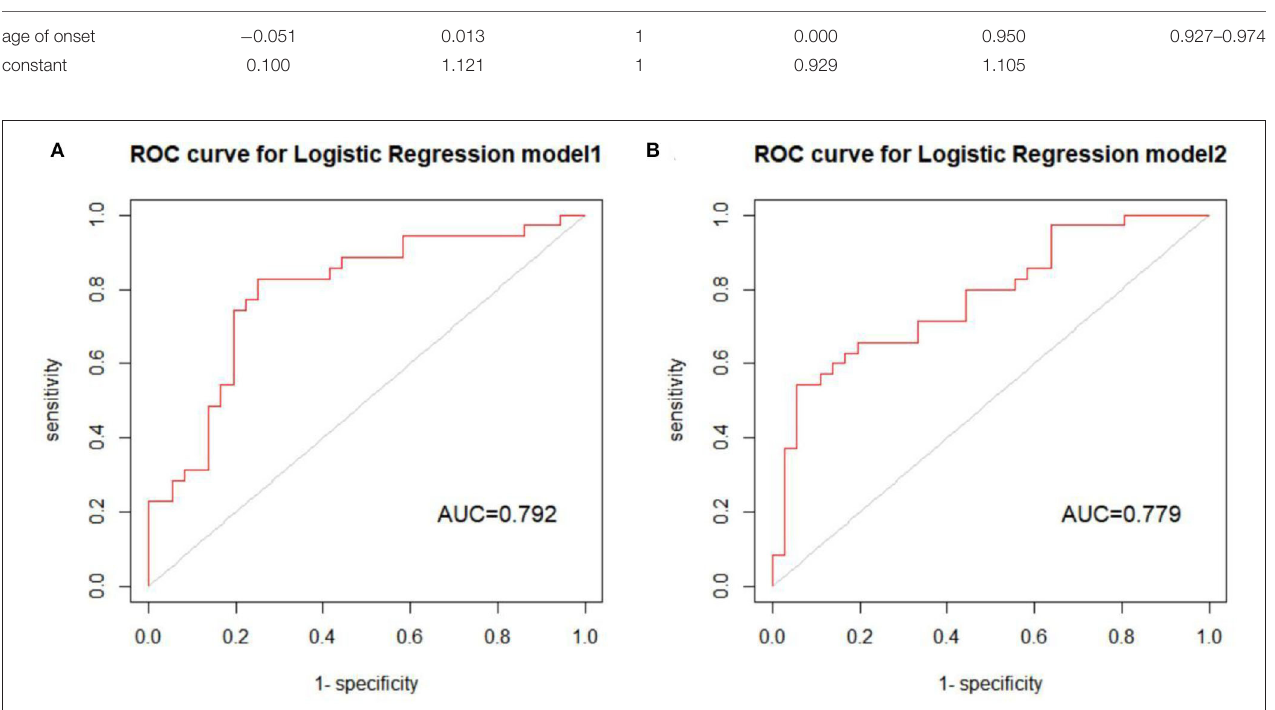
model1 was higher than model2, however, there is no significant difference between the AUC value of model1 and model2 using the delong test ( p -value = 0.805). The calibration curve of model2 ( Figure 3A ) was closer to the diagonal dotted line than that of model1 ( Figure 3B ), suggesting that model2 had a better predictive effect. It could be seen from the DCA curve